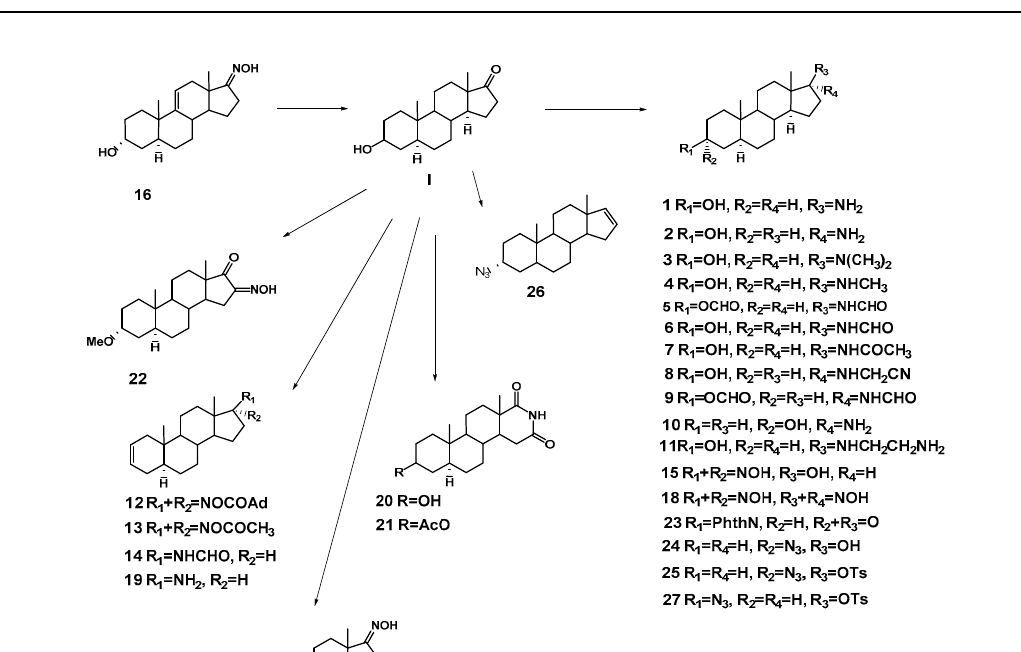
Scheme 1. Synthetic routes of compounds 1–27 .